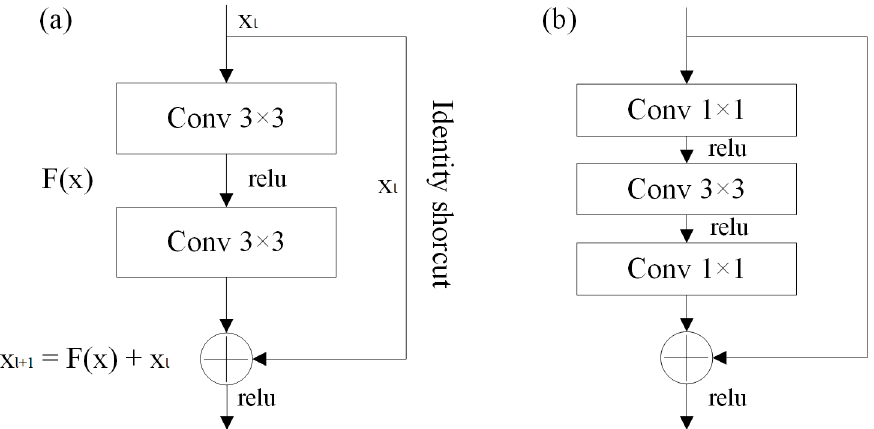
Figure 6. Residual block, ( a ) plain residual block, ( b ) bottleneck residual block.